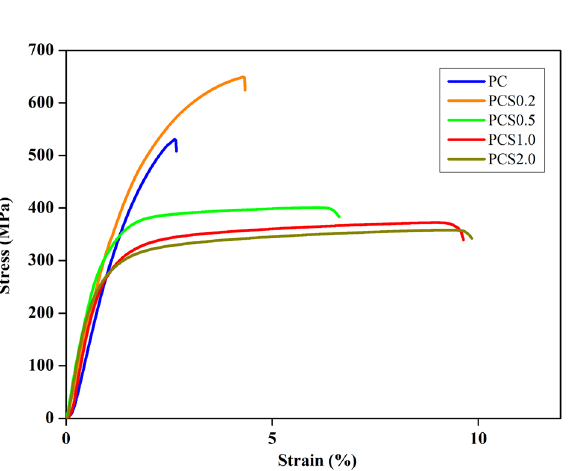
Figure 3. Top-view morphologies of various Cu electroplated layers captured by ( a ) an optical microscope and ( b ) a SEM.